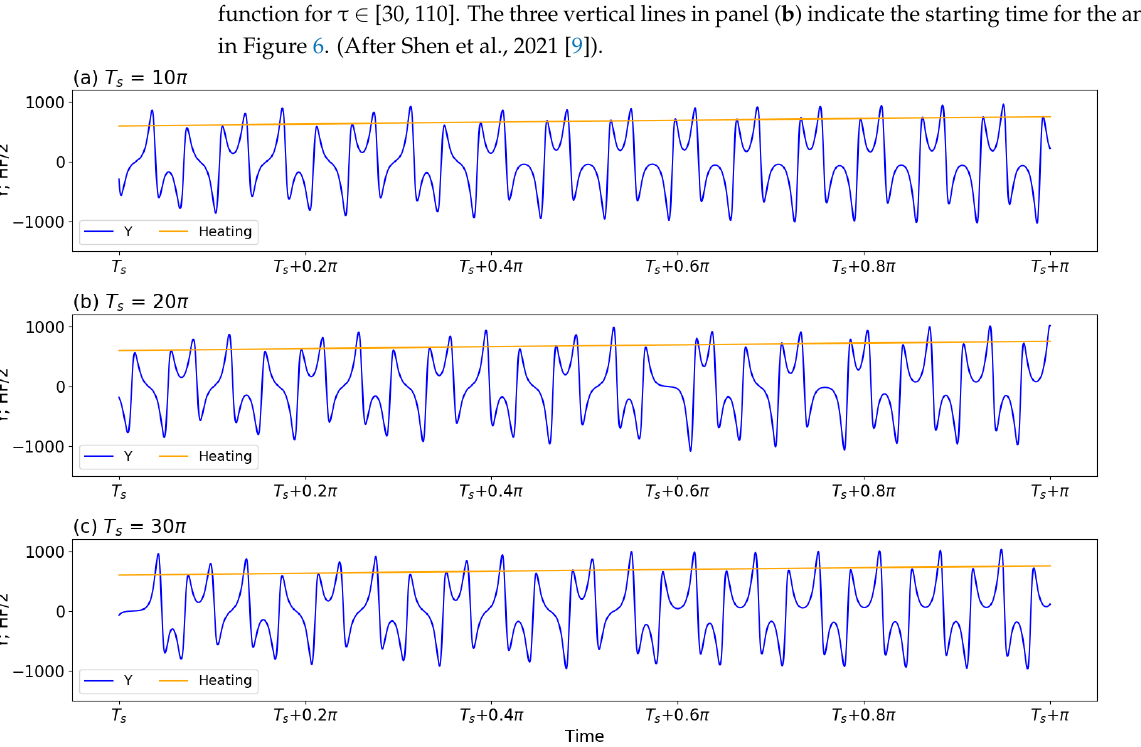
Figure 6. Panels ( a – c ) display the same trajectory during three different time intervals of τ ∈ [ Ts , Ts + π ], with the starting time Ts equal to 10π, 20π, and 30π, respectively. The orange line in each panel represents the half value of the heating function.